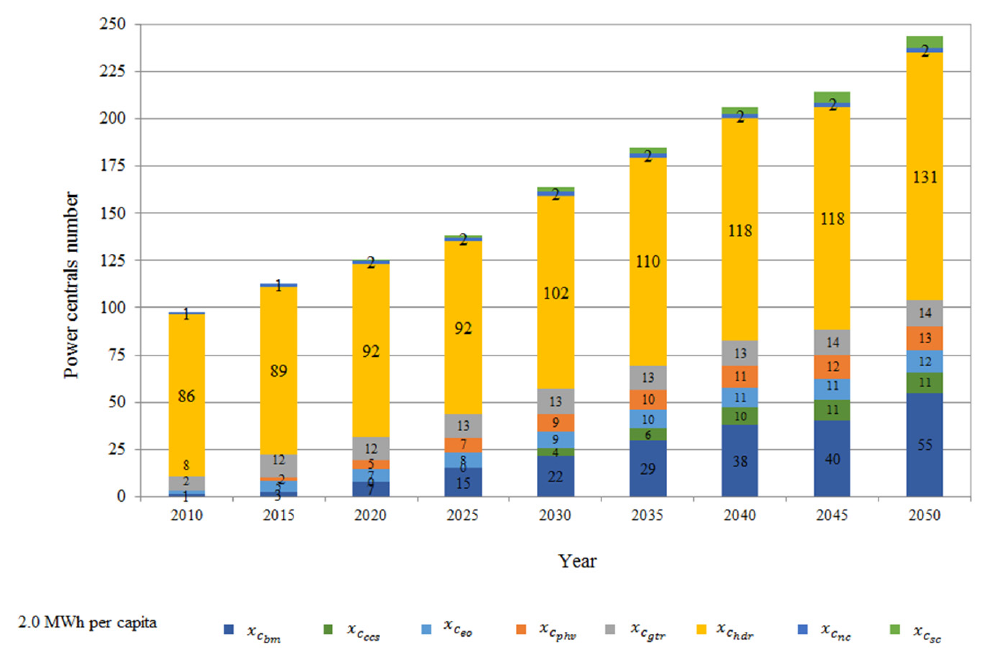
Figure 18. Optimized power plants number from clean energy resource for 2.0 MWh per capita demand with the CVF model.